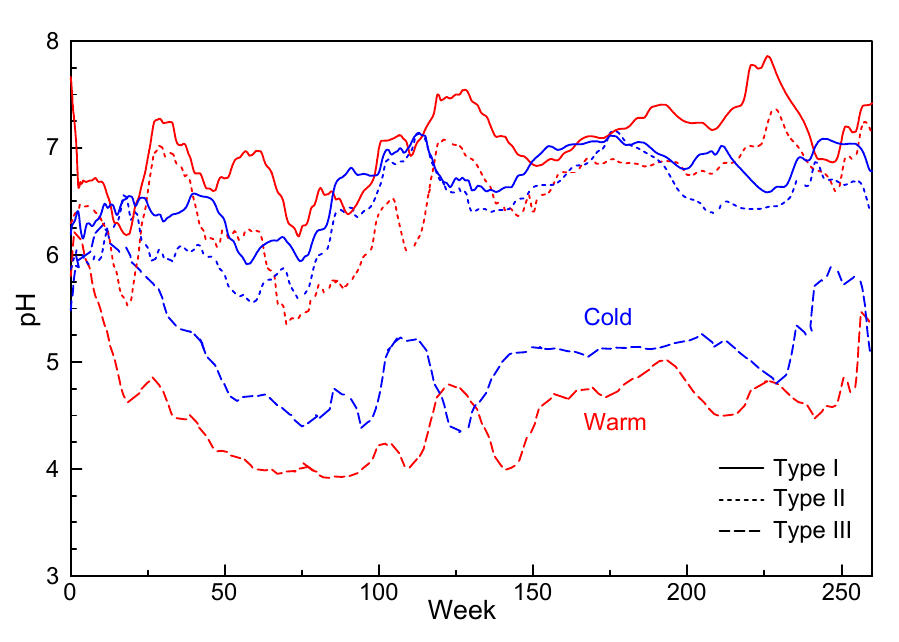
Figure 3. Temporal variation (moving average trendline of a 5-data point window) of the pH of leachate from the warm and cold humidity